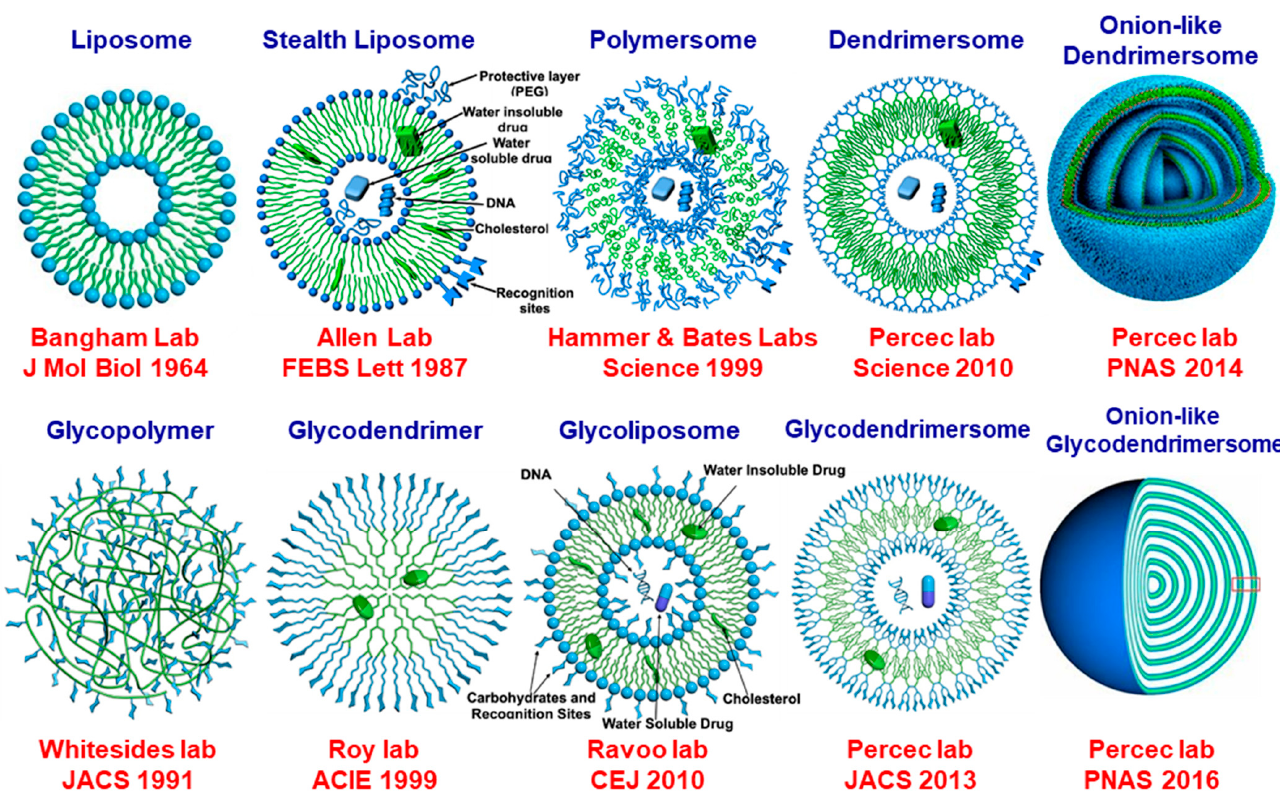
Figure 20. The development and structures of liposomes, stealth liposomes, polymersomes, den- drimersomes, onion-like dendrimersomes, glycopolymers, glycodendrimers, glycoliposomes, gly- codendrimersomes, and onion-like glycodendrimersomes.